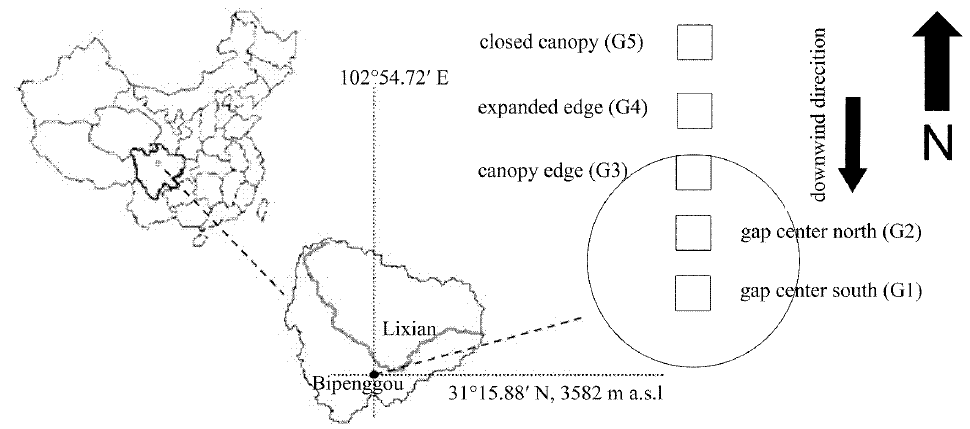
Figure 1. Experimental layout in all experimental gaps by gap position. G1 to G5 were located from gap center to closed canopy. Abbreviations: G1=gap 1, gap center south; G2=gap 2, gap center north; G3=gap 3, canopy edge; G4=gap 4, expanded edge; G5=gap 5, closed